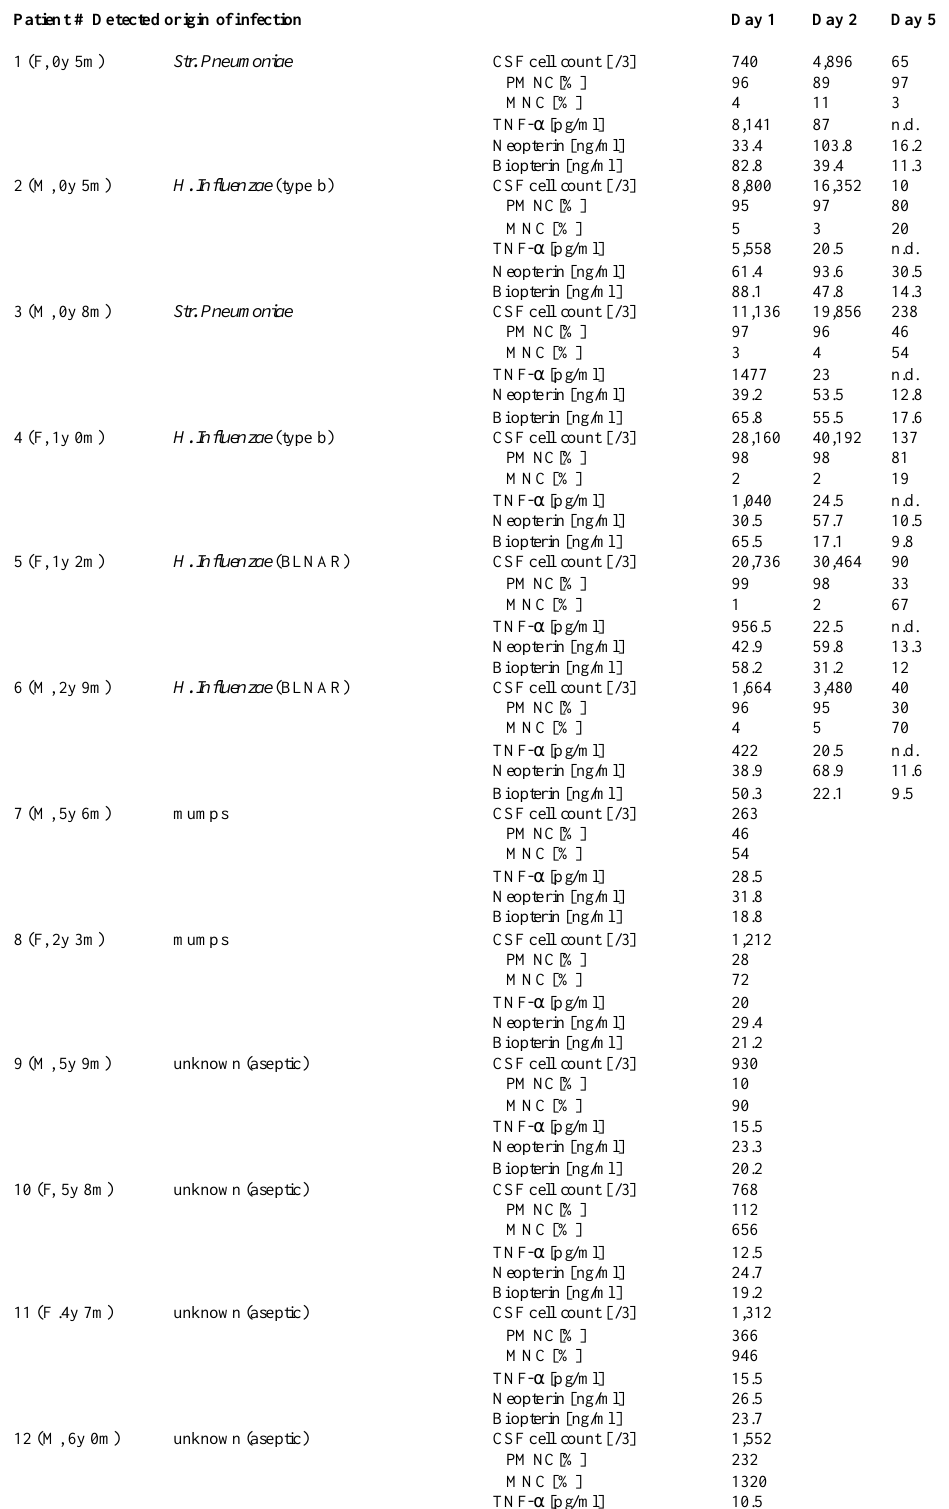
Table 1: Patients' clinical data (modified from those given in ref. 7) and cell counts in cerebrospinal fluid (CSF) including polymorphonuclear cells (PMNC) and mononuclear cells (MNC) and tumor necrosis factor- a (TNF- a) , neopterin and biopterin concentrations on the day of diagnosis and during follow-up. Patient # Detected origin of infection Day 1 Day 2 Day 5 1 (F, 0y